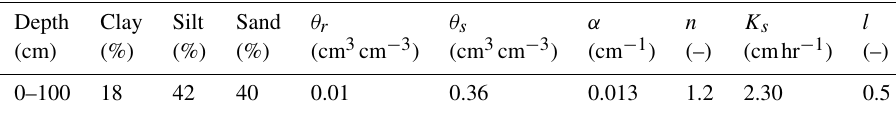
Table 2. Soil parameters at the Lavalette experimental station used in Hydrus-2D. θ r and θ s denote, respectively, the residual and saturated volumetric soil water contents, α and n are empirical shape parameters of the Van Genuchten–Mualem model, K s is the soil hydraulic conductivity at saturation and l is a pore connectivity parameter.